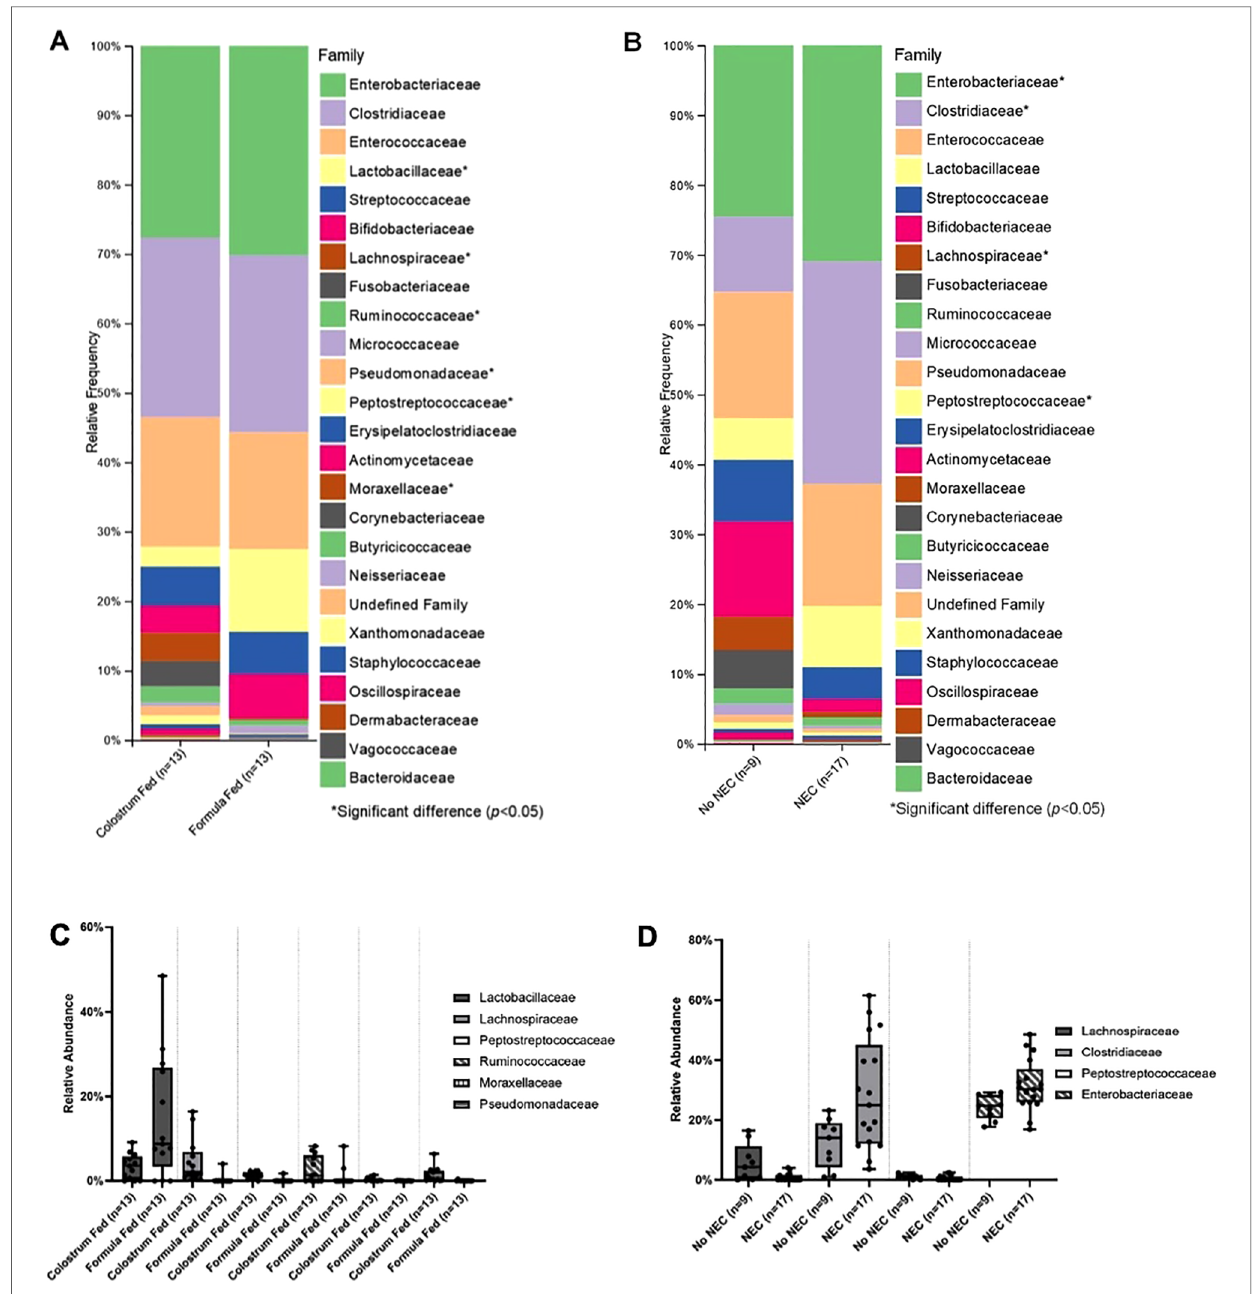
FIGURE 8 Family level taxonomic abundance. Family level taxa distribution within ( A ) feeding regimen and ( B ) occurrence of NEC. Bars represent mean relative percentage of each corresponding bacterial family. Distribution of signi fi cantly different families within ( C ) feeding regimen and ( D ) occurrence of NEC as box and whisker plots that denote minimum, maximum, and interquartile range values. For all relative abundance data, pairwise comparisons between groups were made using the Kruskal-Wallis test ( p